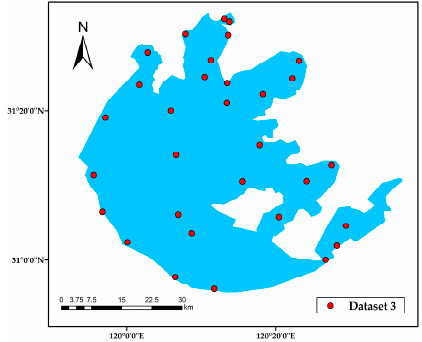
Figure 4. Locations of Dataset 3 collected in Taihu Lake.